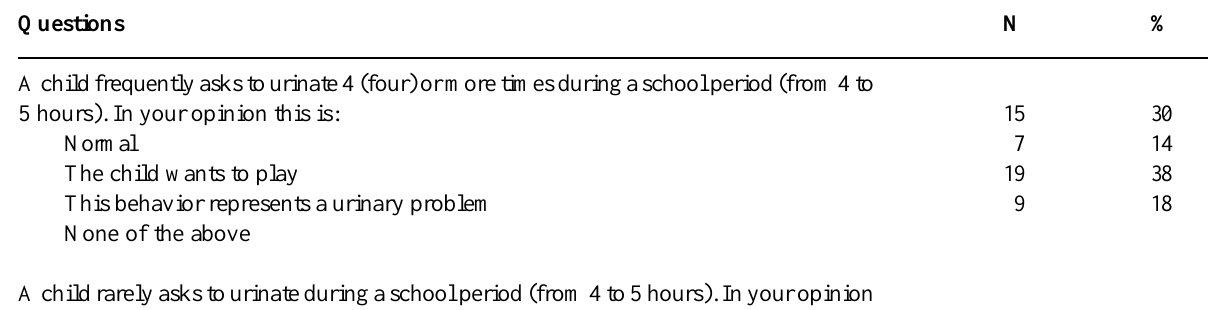
Table 1 – Distribution of teachers’ answers for each question.